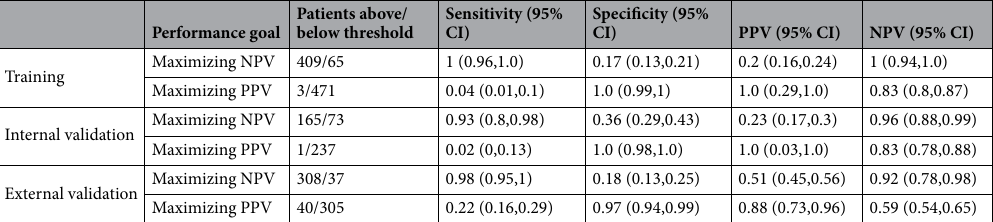
Table 5. Negative and positive predictive values for the Elastic net LR model and outcome of in-hospital mortality.